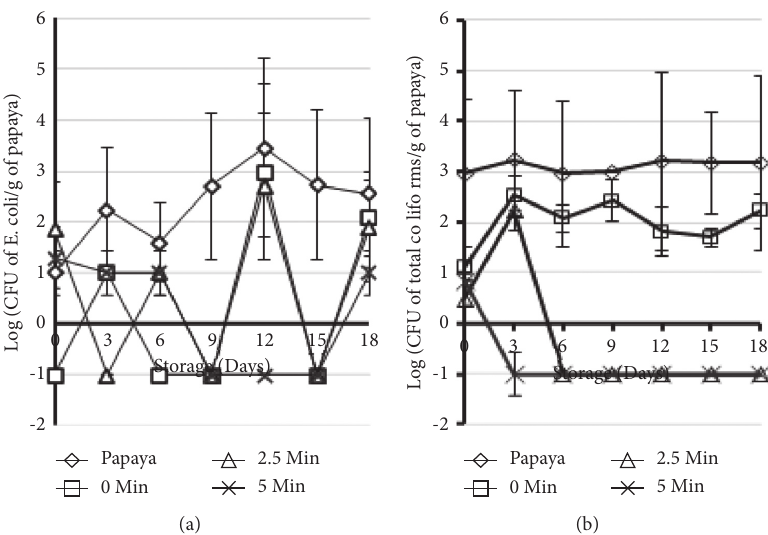
Figure 3: The microbial population on fresh-cut papaya fruit stored at 4 ° C for 18 days. (a) Papaya inoculated with E . coli . (b) Papaya not